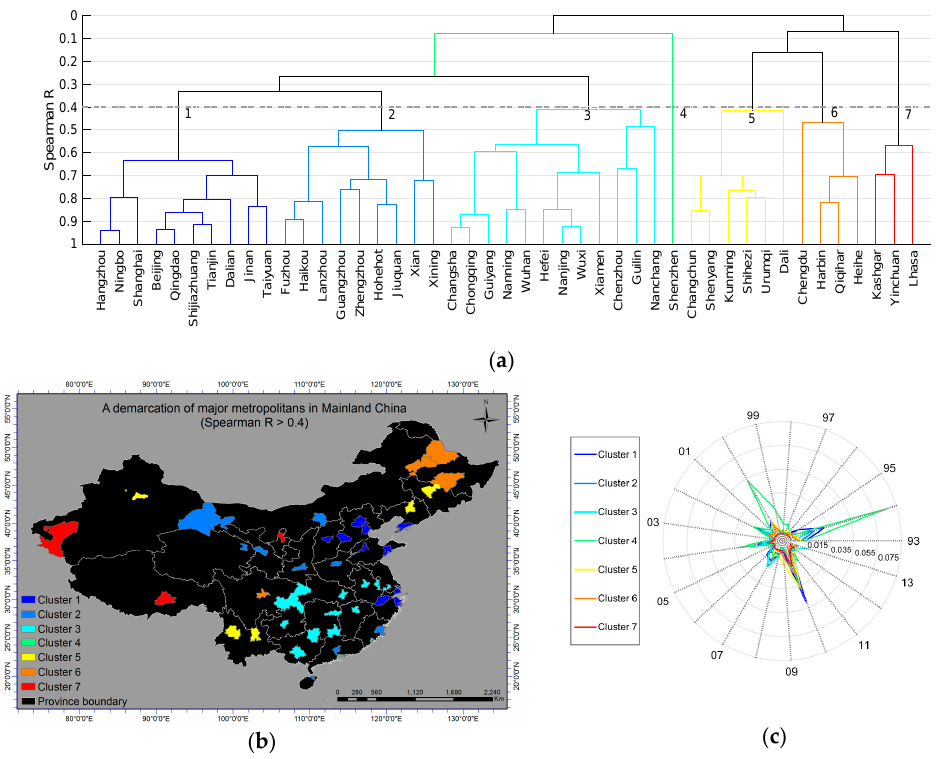
Figure 6. Clustering of major metropolitans: ( a ) Dendrogram of major metropolitans; ( b ) Map of the 7 clusters; ( c ) Polar plot of IL over time with respect to the clusters.